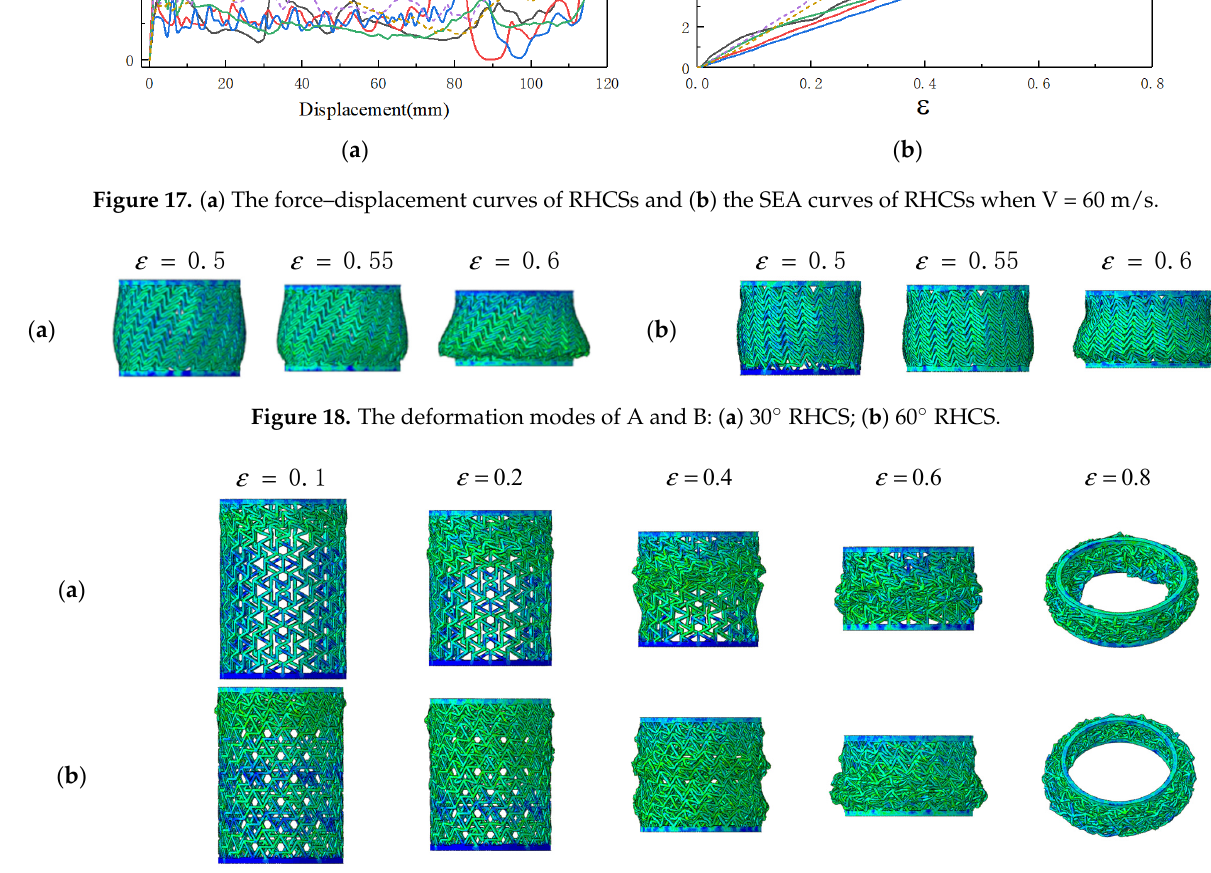
Figure 19. The deformation process of composite RHCSs when V = 60m/s: ( a ) [30°/ − 30°] RHCS; ( b ) [60°/ − 60°] RHCS.